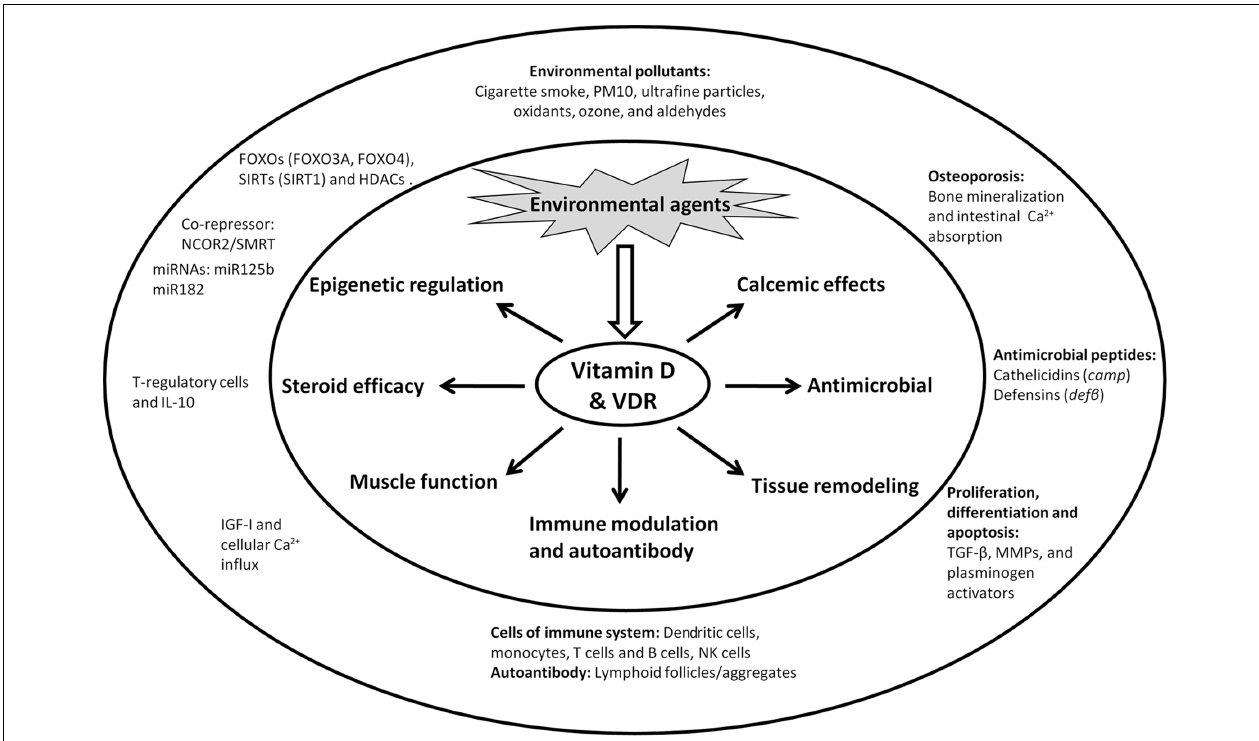
vitamin D-mediated deregulation.The major cellular and molecular function affected due to vitamin D/VDR deregulation includes: calcemic effects, antimicrobial peptide gene activation, tissue remodeling, immune modulation and autoantibody production, muscle function, steroid efficacy, and epigenetic